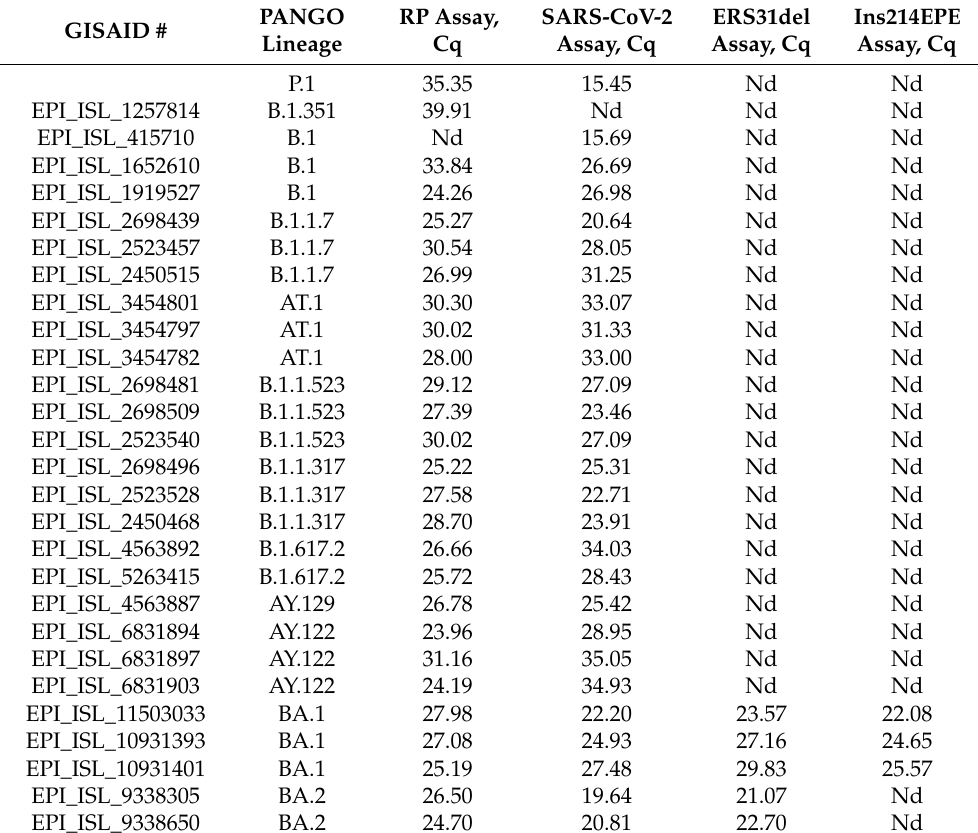
Table 2. Assessment of the analytical specificity of the assays to different SARS-CoV-2 variants. “Nd”—“Not detected”.